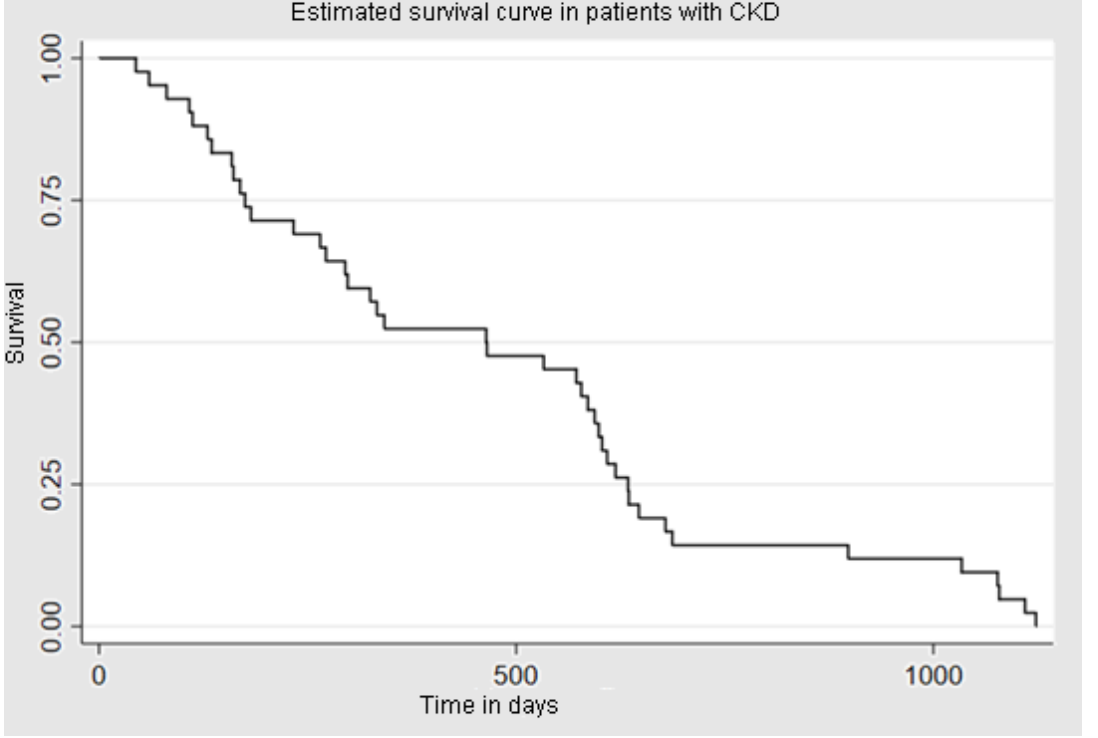
FIGURE 3 - Estimated Kaplan-Meier survival curve over 3 years of the study.